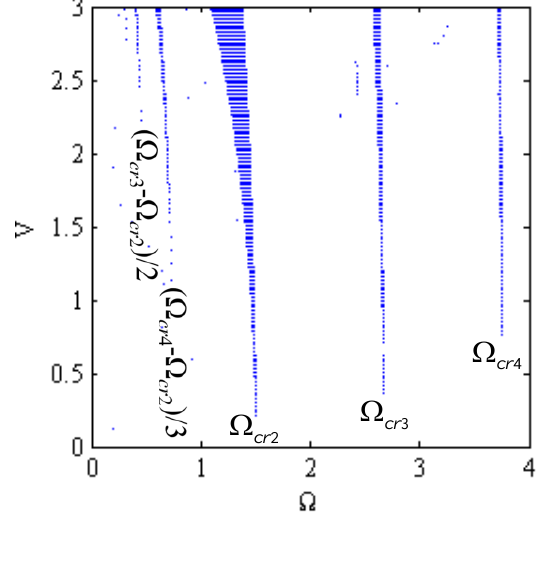
Figure 4. The instability of a micro ring driven by a traveling electrostatic force with the traveling speed of Ω and the driving voltage of V